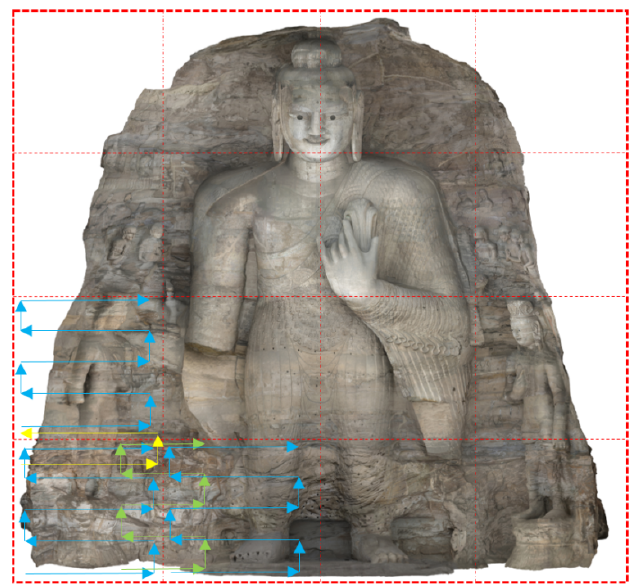
Figure 4. Orthophoto acquisition sequence (arrow indicates camera moving direction).